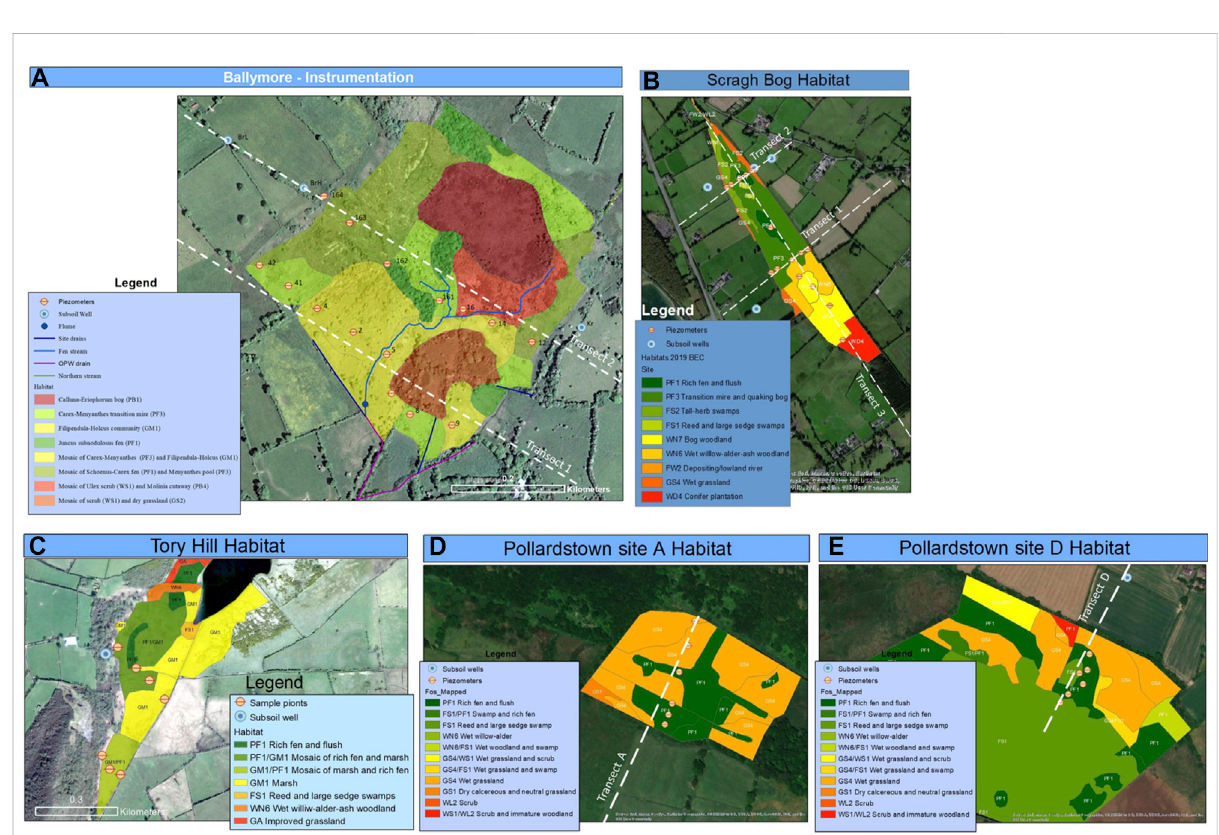
FIGURE 1 Habitat maps fens also showing the location of instrumentation transects (A) Ballymore (Regan and Connaghan, 2017) (B) Scragh Bog (BEC, 2019) (C) Tory Hill (Regan and Conaghan, 2016) (D) Pollardstown Site A (BEC, 2019) (E) Pollardstown Site D (BEC,